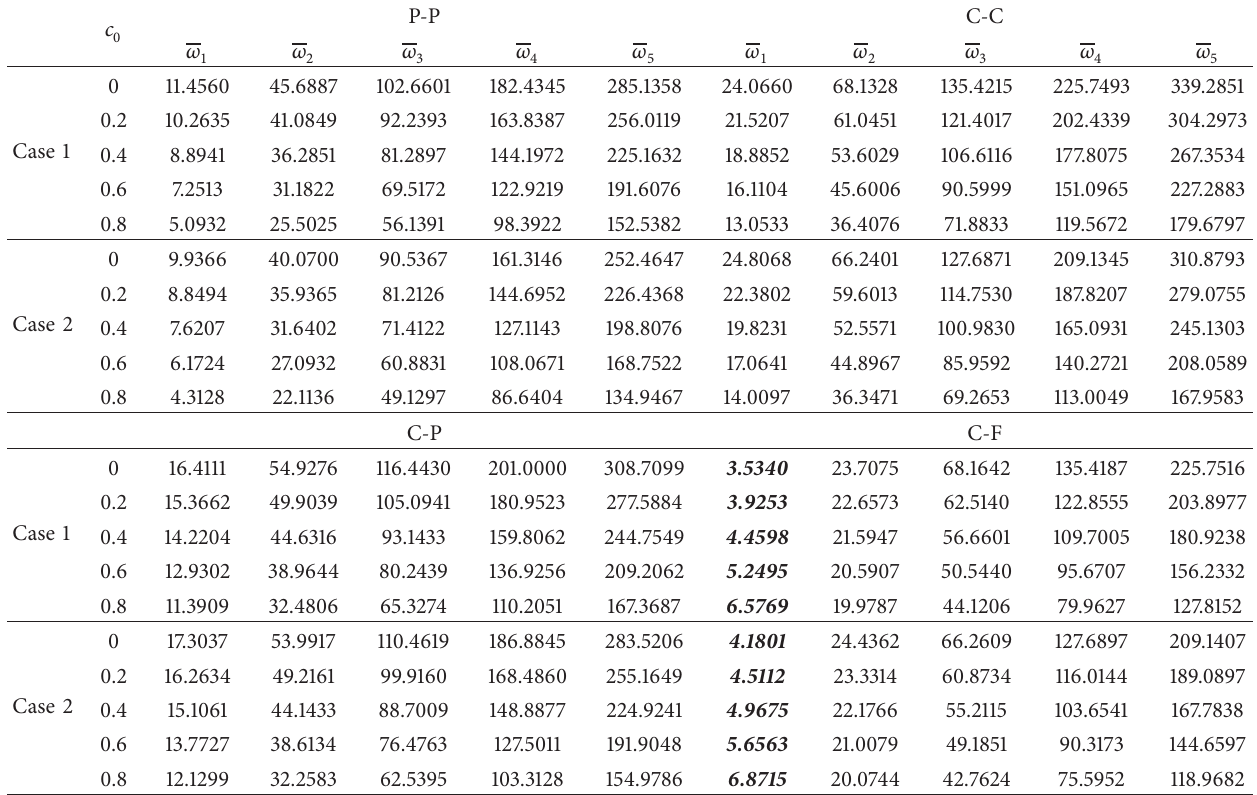
Table 11: Nondimensional natural transverse frequencies 𝜔 𝑖 for axially FG tapered beam with respect to taper ratio 𝑐 𝑏 = 𝑐 ℎ = 𝑐 0 , 𝛼 = −10 . 𝑐